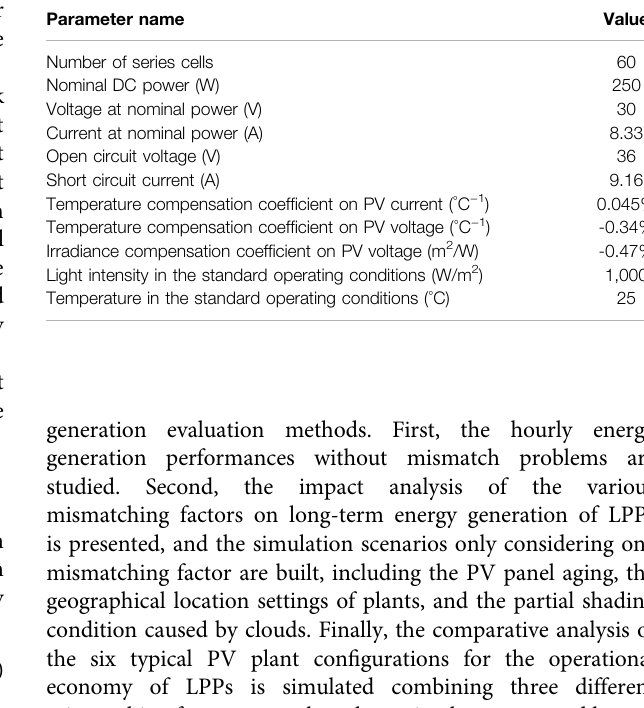
TABLE 1 | Parameter values of a PV